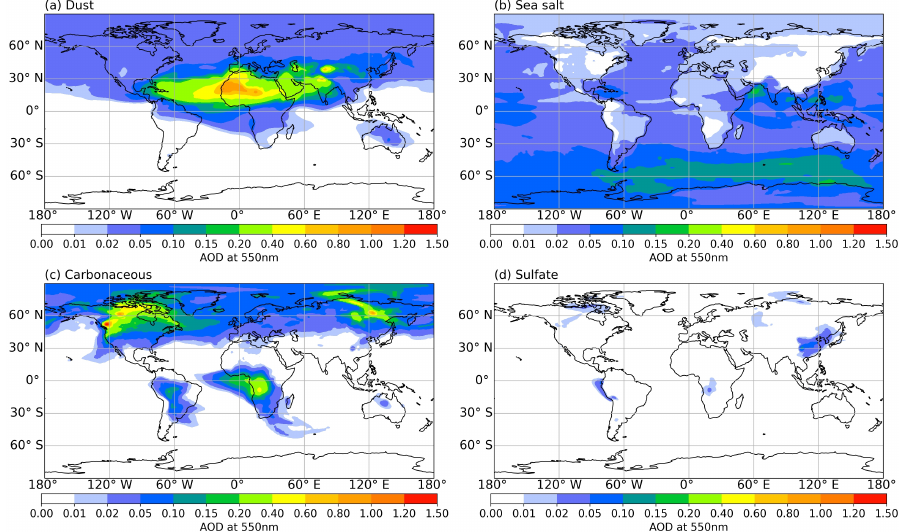
Figure 2. Mean AOD at 550 nm of ( a ) dust ( b ) sea salt ( c ) carbonaceous and ( d ) sulfate aerosols from NGAC v2 over 1–28 August